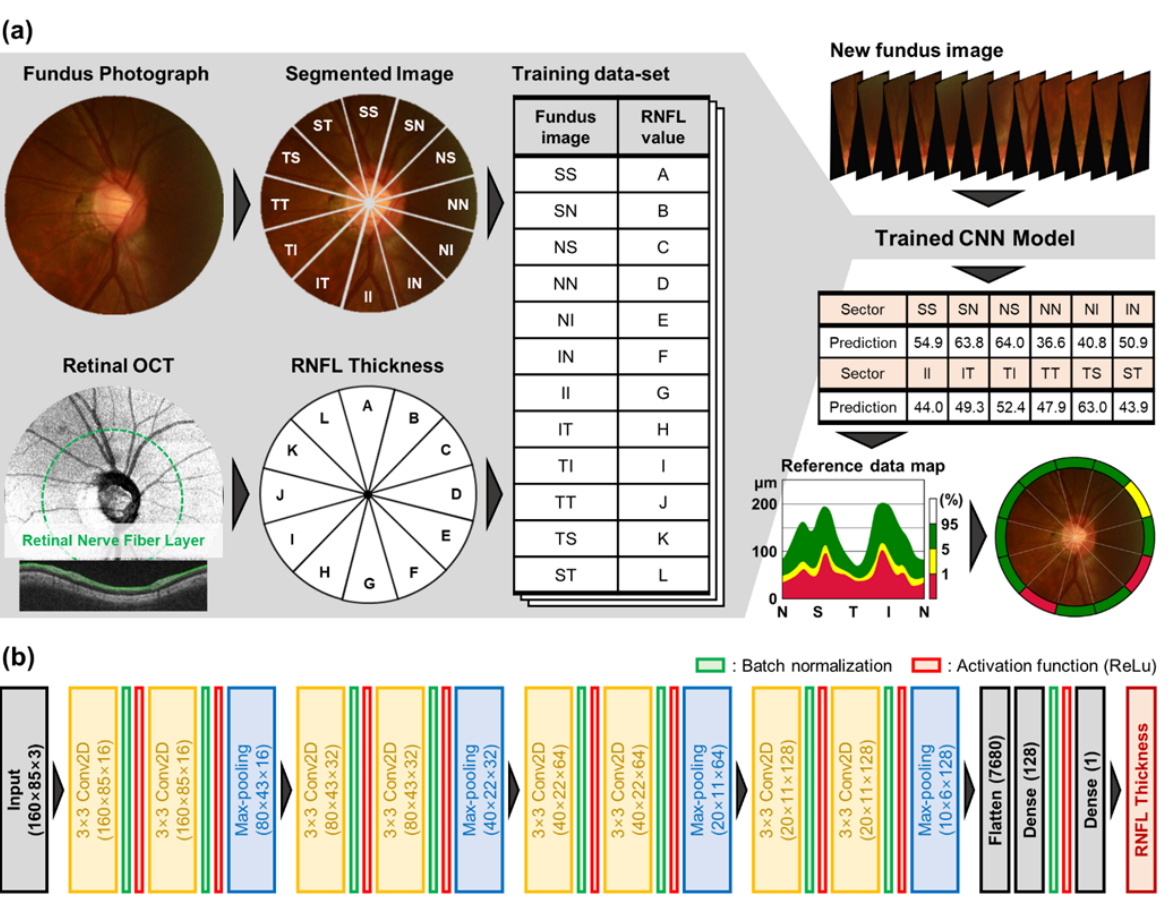
Figure 1. Overview of the proposed study. ( a ) Fundus images and OCT images were segmented into 12 subsections and then the segmented images were paired with the RNFL thickness measurements from OCT to train the model. The trained CNN model can predict RNFL thickness from a subdivided retinal image. The label of the thinning level for an estimated RNFL of a given region is determined by comparison with the normative reference data. ( b ) The details of CNN architecture for RNFL thickness estimation from segmented retinal fundus images are presented. Note that the model for estimation of global RNFL has the input size as 320 × 320 × 3 and thus sizes of the following convolution blocks were adjusted.